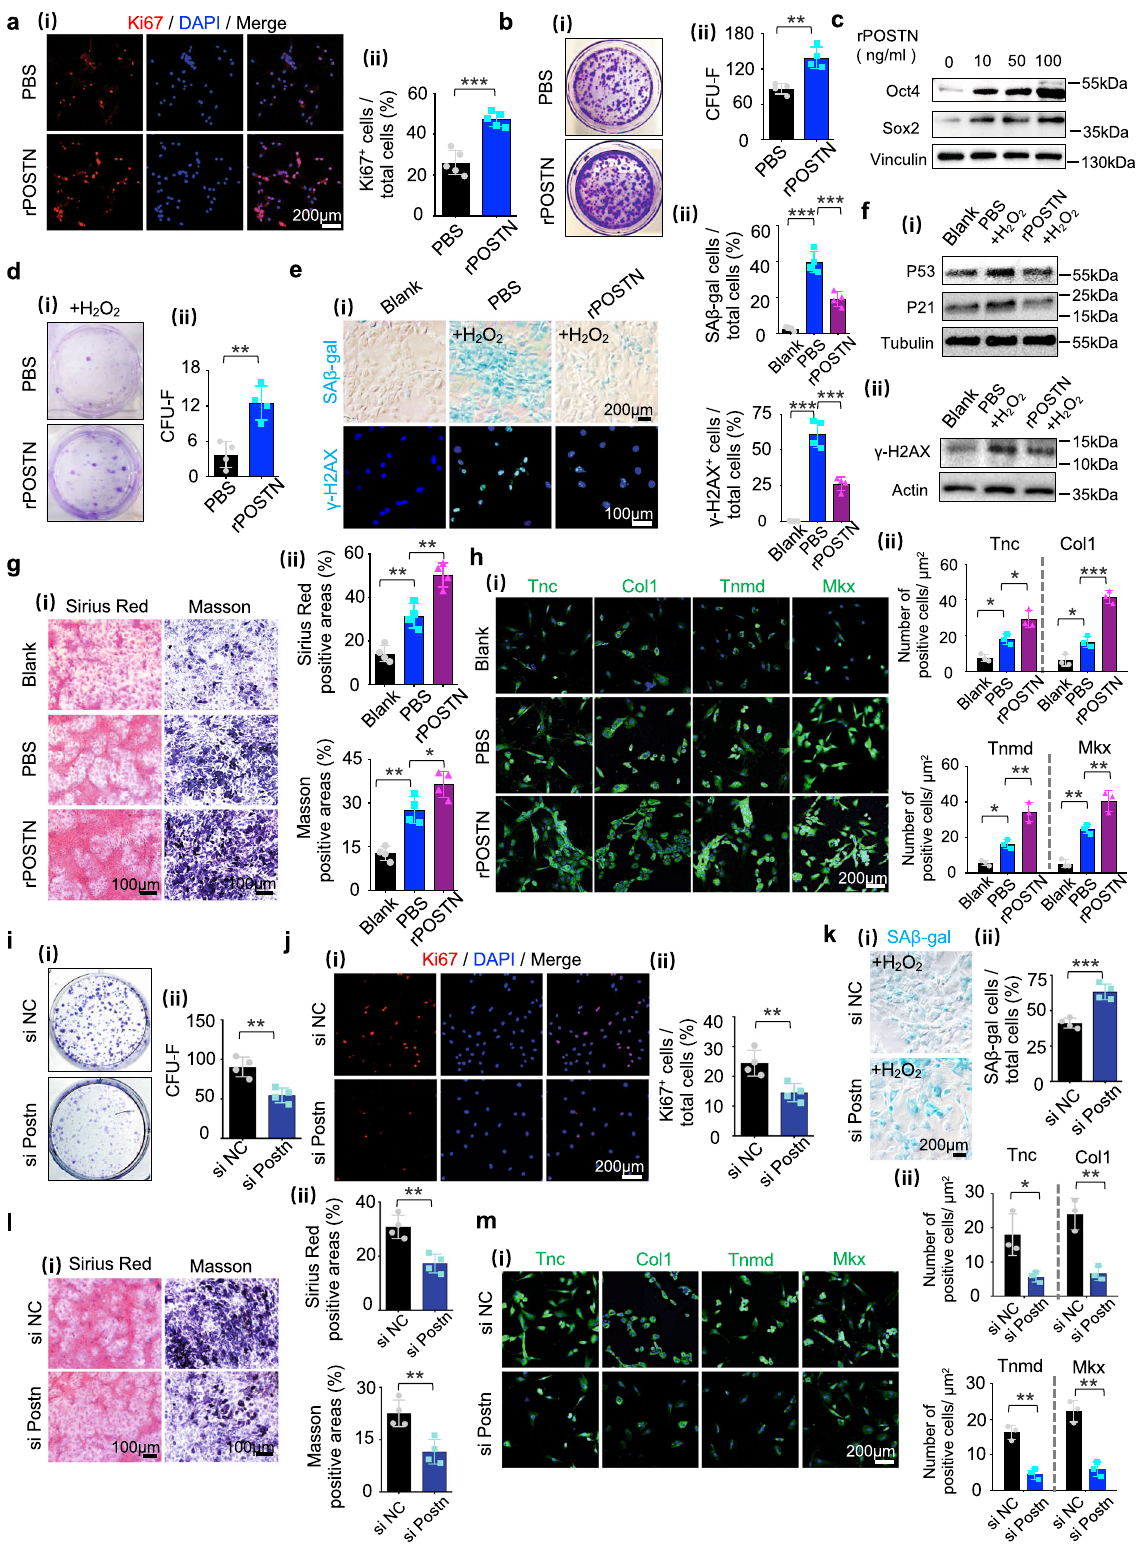
Sox2 (Supplementary Fig. 2f); it also partially impaired the self- renewal capacity, proliferation capacity, oxidative stress resistance capacity, and multi-lineage differentiation potentials of TSPCs (Fig. 2i – m, Supplementary Fig. 2g – i). The greatest obstacle to the application of adult stem cells in tissue engineering is that they undergo spontaneous